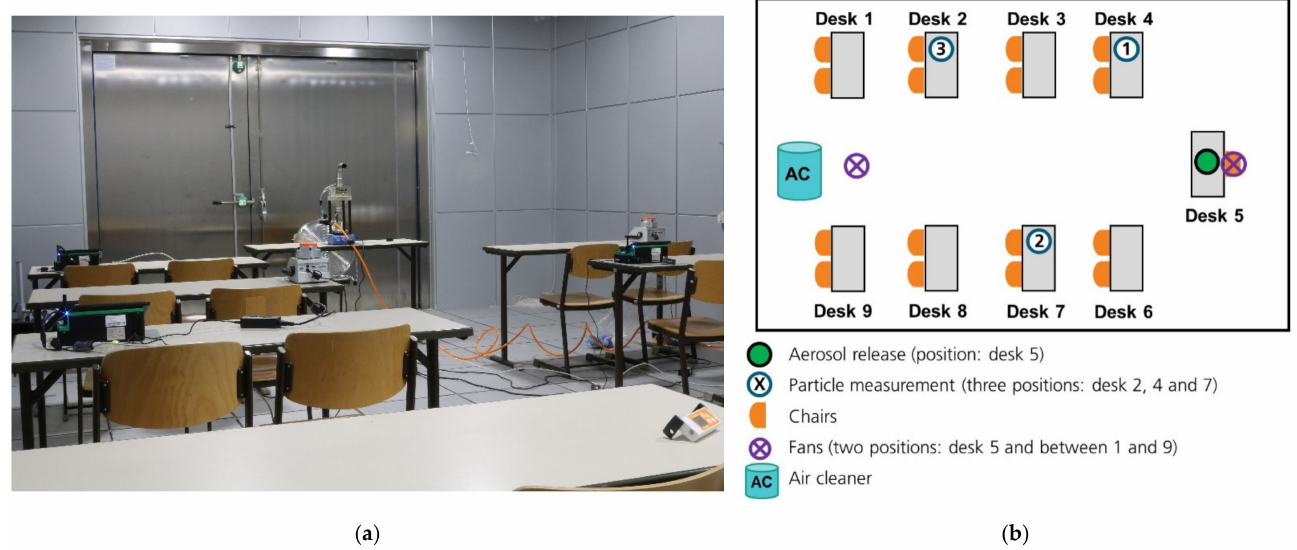
Figure 1. IATC test setup with one aerosol generator, two fans, one air cleaner, and three particle measurement devices: ( a ) view towards aerosol generator; ( b ) positions of the aerosol generator, three particle counters, and the air cleaner (AC) in the test room.